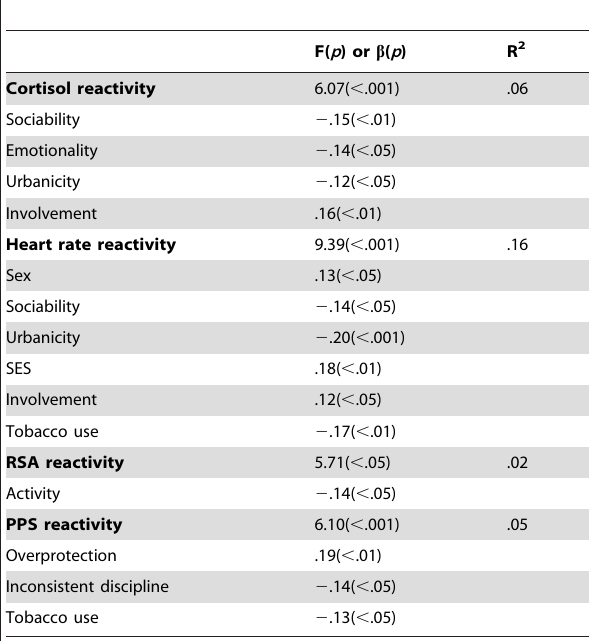
Table 5. Results of the multiple linear regression models, predicting each stress response in the adolescent